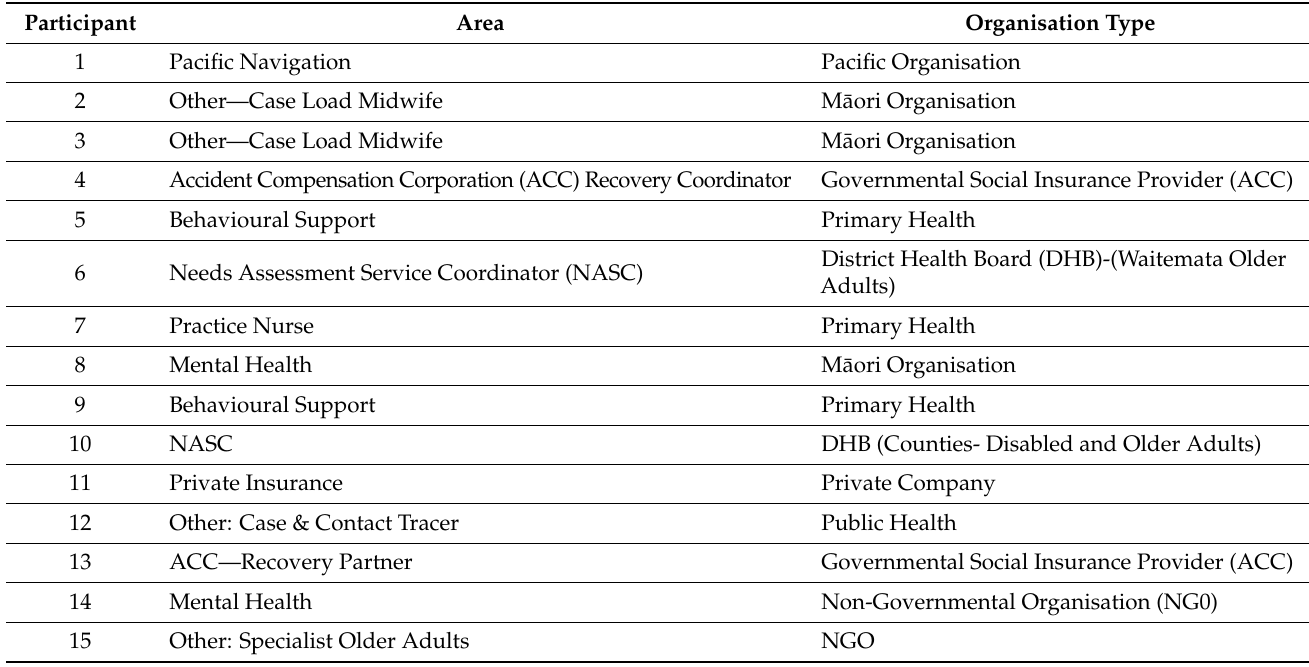
Table 2. Overview of Interview Participant’s